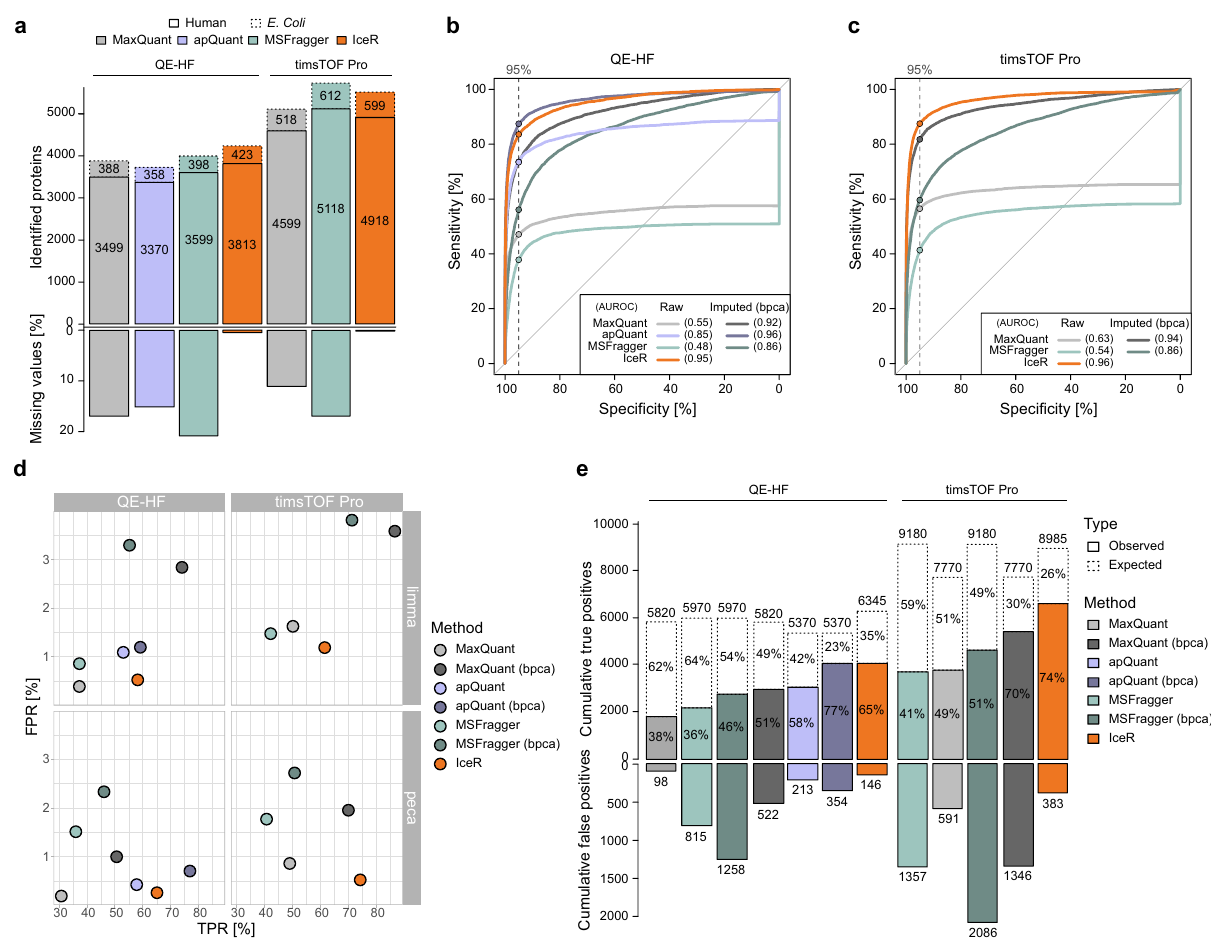
Fig. 5 Application of IceR to timsTOF Pro proteomics data. a Comparison of numbers of identi fi ed human (solid box) and E. coli (dashed box) proteins as well as fraction of missing values in the in-house generated E. coli spike-in data set analysed on a Q Exactive HF (QE-HF) and a timsTOF Pro followed by peptide and protein quanti fi cation using MaxQuant (grey), apQuant (purple), MSFragger (green) or IceR (orange). b Receiver operating characteristics (ROC) over all (15) pairwise differential expression analyses on QE-HF data analysed by MaxQuant (light grey), MaxQuant with bpca imputation (dark grey), apQuant (purple), apQuant with bpca imputation (dark purple), MSFragger (green), MSFragger with bpca imputation (dark green), or IceR (orange) on peptide-level using peca. Area under the ROC (AUROC) per condition is indicated. Dashed vertical lines and respective dots represent observed sensitivity at 95% speci fi city per method. c As in b but showing results for timsTOF Pro data. d True and false-positive rates over all (15) pairwise DE analyses using limma or peca for QE-HF and timsTOF Pro data for MaxQuant (grey), MaxQuant with imputation (dark grey), apQuant (purple), apQuant with bpca imputation (dark purple), MSFragger (green), MSFragger with bpca imputation (dark green), and IceR (orange). e Cumulative true and false positives over all (15) pairwise DE analyses for QE-HF and timsTOF Pro data for MaxQuant (grey), MaxQuant with bpca imputation (dark grey), apQuant (purple), apQuant with bpca imputation (dark purple), MSFragger (green), MSFragger with bpca imputation (dark green), and IceR (orange) when using peca. True positive rates are indicated. bpca — Bayesian principal component analysis.